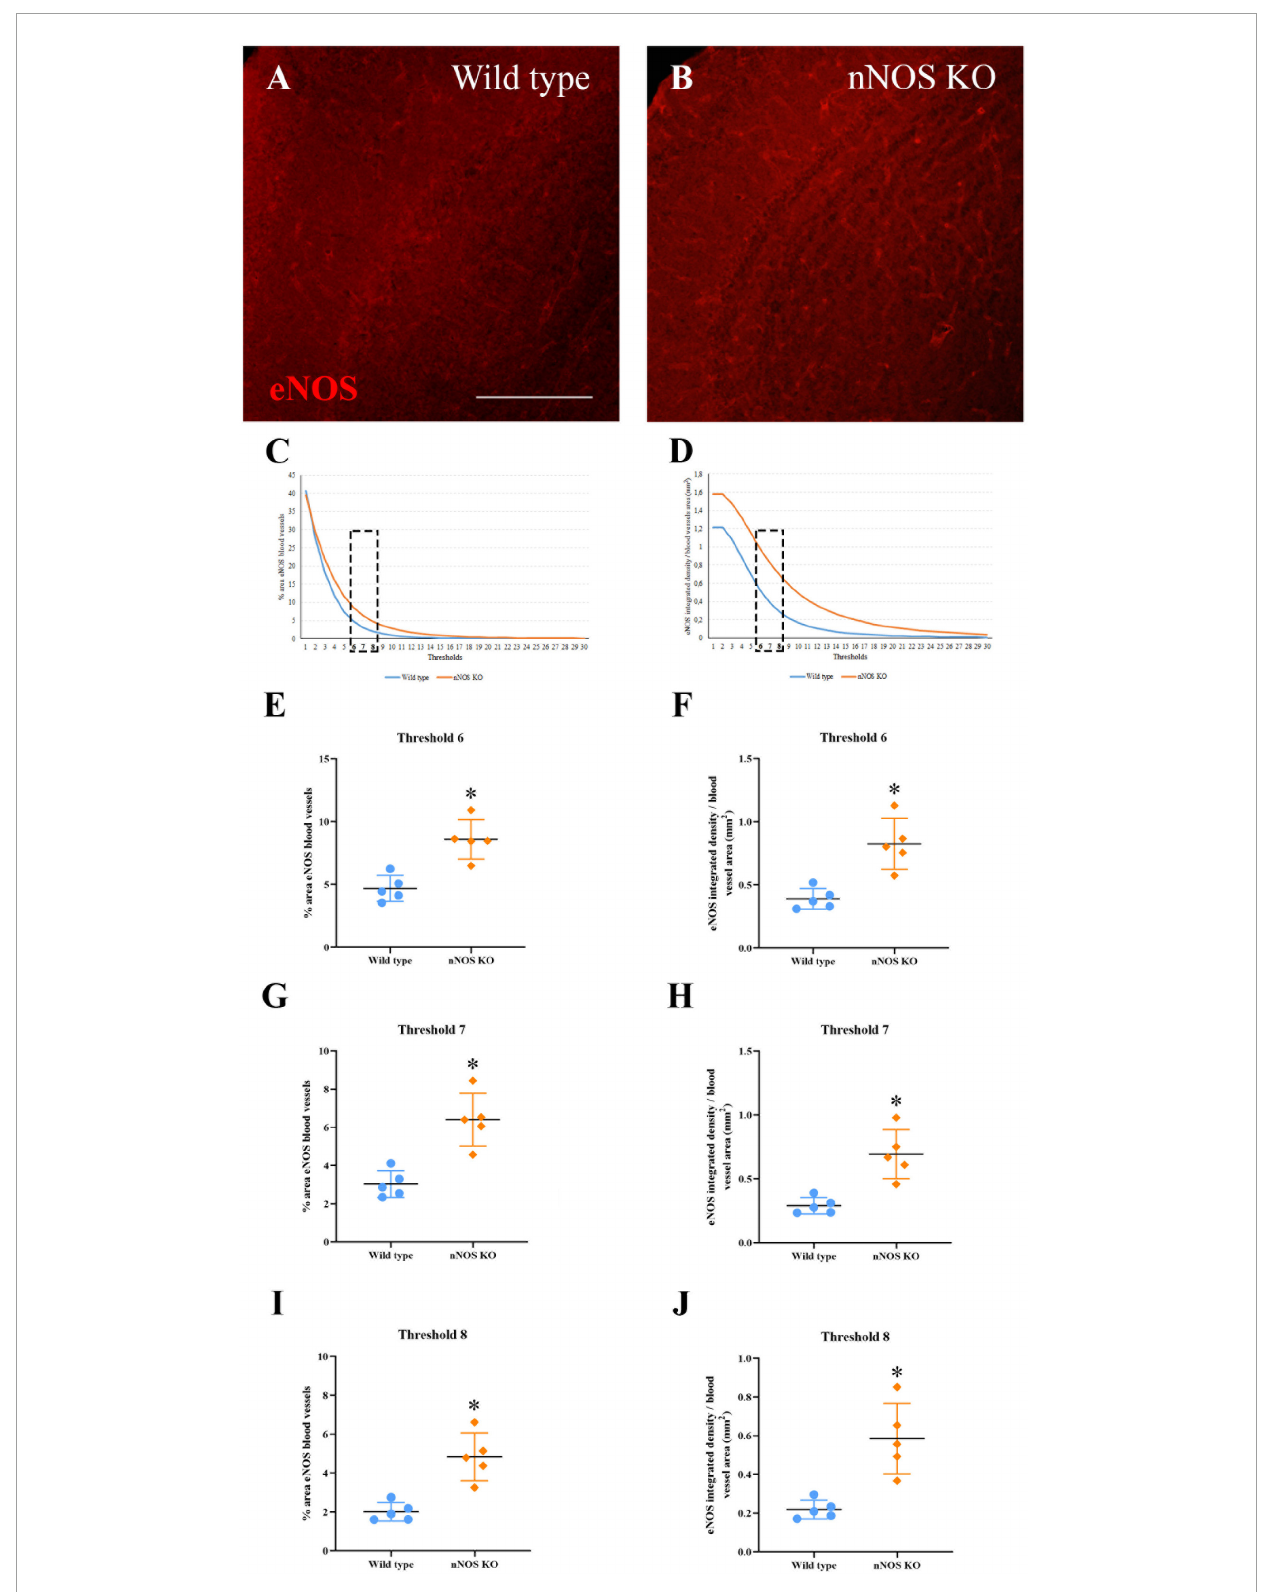
FIGURE4 Expression of eNOS in the MOB. (A,B) Immunolabeling of eNOS (red) in blood vessels of wild-type (A) and nNOS-KO mice (B) . (C,D) Curves corresponding to the threshold values at different exposures for the area occupied by the labeled blood vessels (C) and the integrated density per area corresponding to eNOS (D) . (E–J) Graph representations summarizing statistical analyses of the percentage occupied by eNOS in the blood vessels (E,G,I) and eNOS integrated density per area (F,H,J) for the three thresholds analyzed (#6, #7, and #8). Note that in the three selected thresholds, there are significant differences between experimental groups for both parameters. ∗ p < 0.05. Scale bar 200 µ